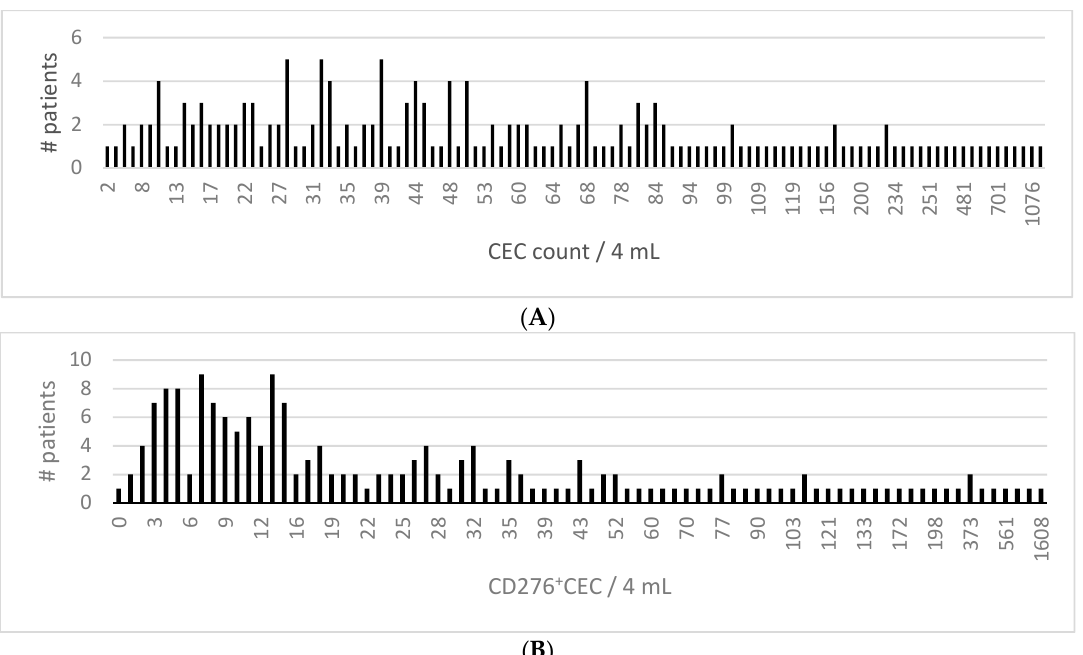
Figure 2. Histograms of (CD276 + ) CEC counts of all available patients ( n = 142). ( A ) CEC counts per 4 mL; median 48.5 CEC/4 mL (interquartile range 65). ( B ) CD276 + CEC counts per 4 mL, median 18 CD276 + CEC/mL (interquartile range 35).